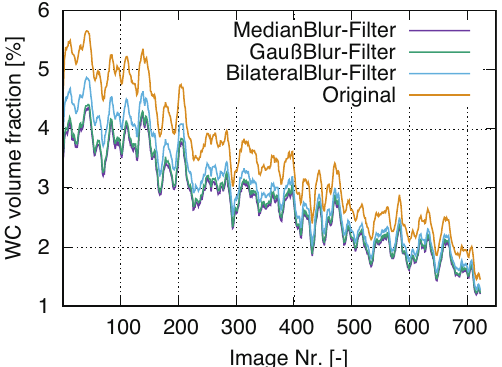
Figure 14. Comparison of WC phase area fractions in each µ CT image among the original and filtered ones, where the filtration is done by three different methods [61].